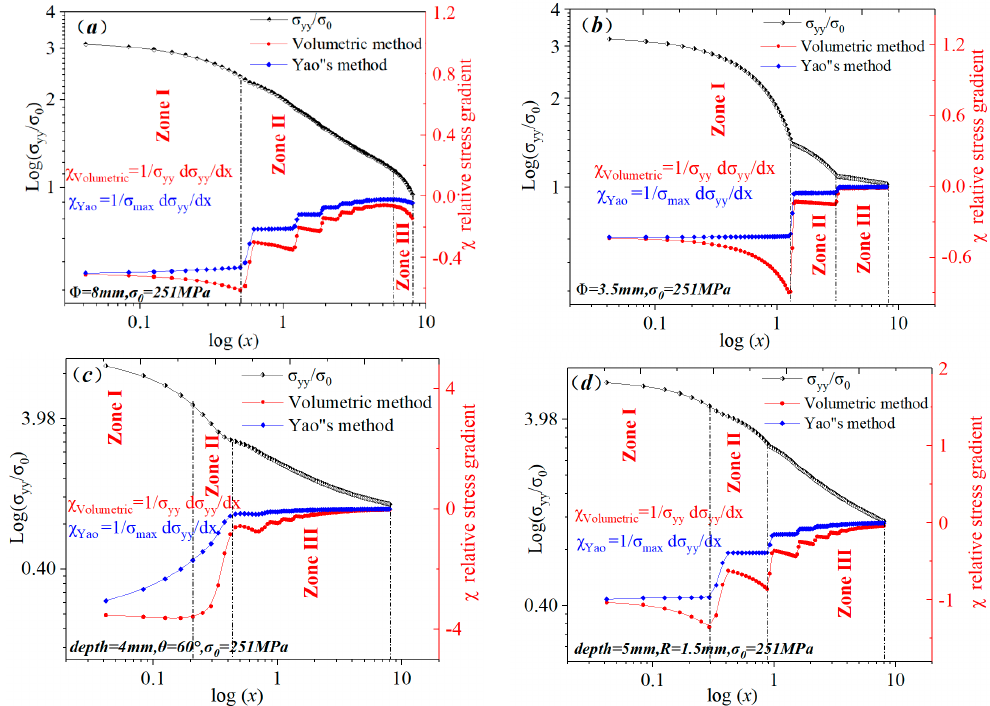
Figure 5. Bi-logarithmic diagrams for stress distributions at the notch bisector of different specimens at the elastic state of material. ( a ) big circle hole plate, ( b ) little circle hole plate, ( c ) sharp V-notch plate, ( d ) U-notch plate.